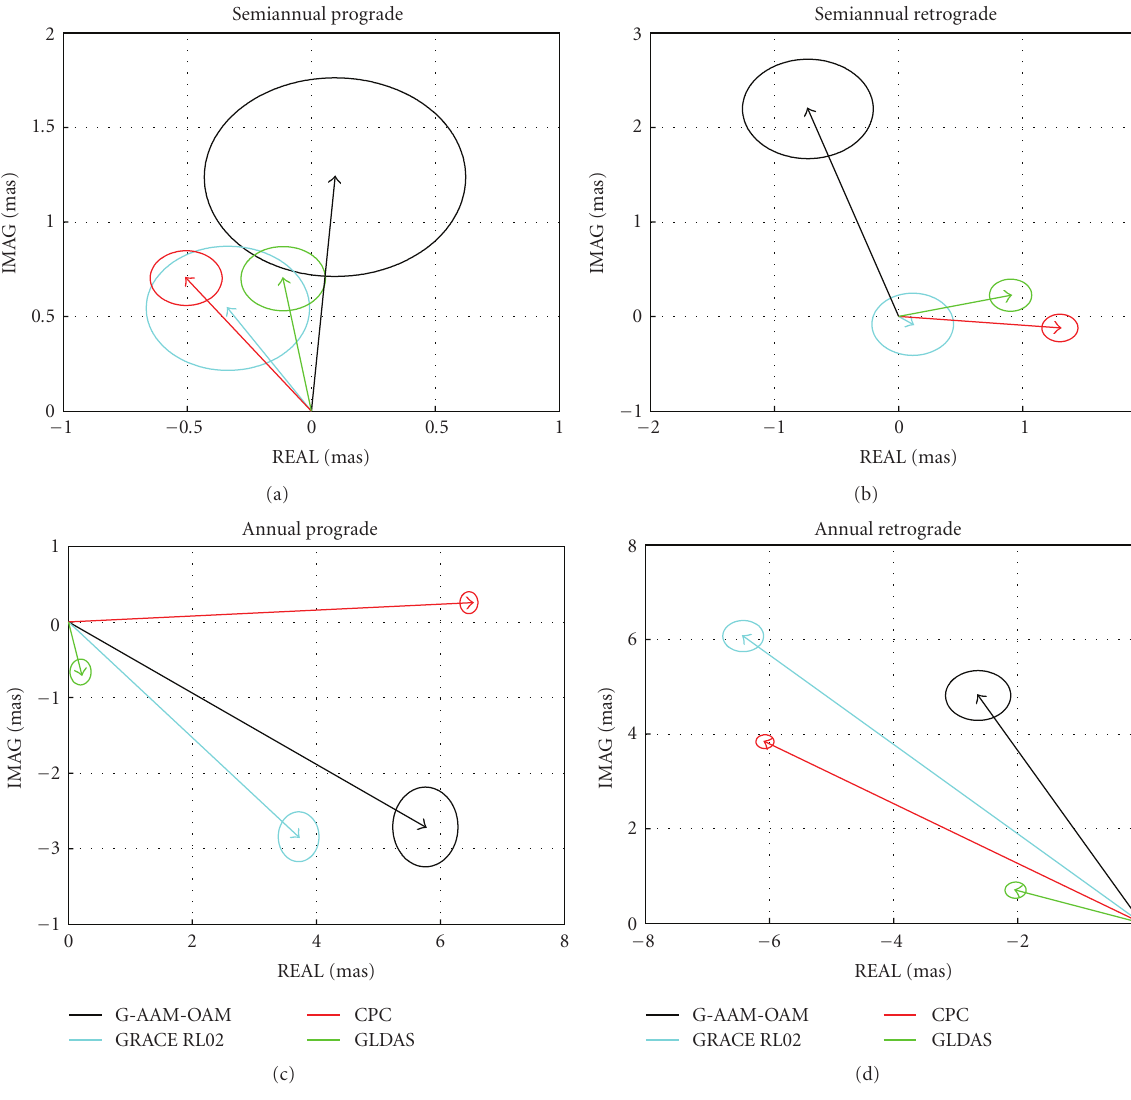
Figure 3: Phasor diagram of seasonal variations. Circles represent the formal errors.